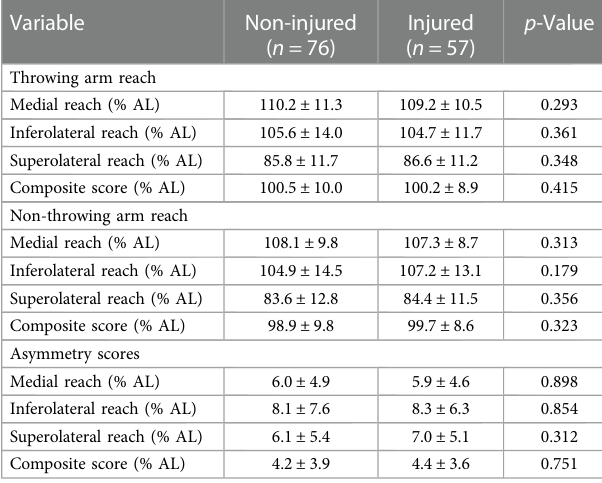
TABLE 5 Normalized upper quarter Y-balance test reach distances and asymmetry scores of adolescent handball